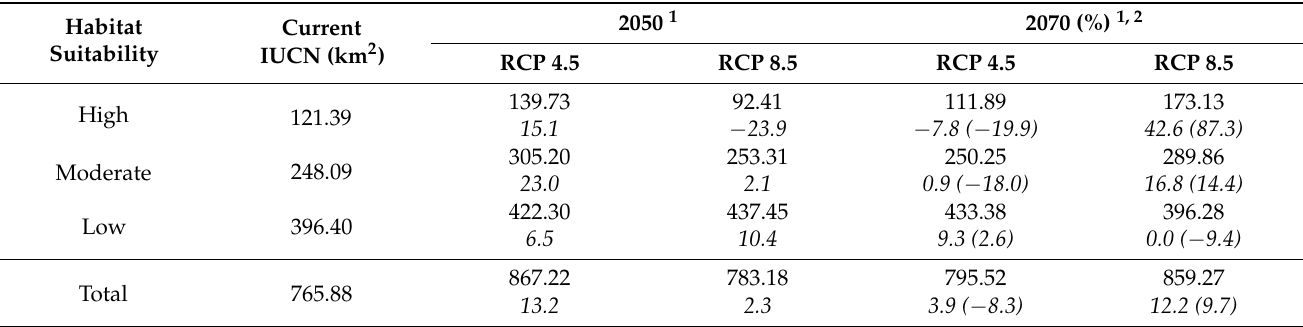
Table 2. Area (km 2 ) of the “existing” IUCN map, which matches the predicted potential distribution under current conditions and variation (%) under climate change scenarios of X. loweryi in Amazonas and San Martin regions (Peru).